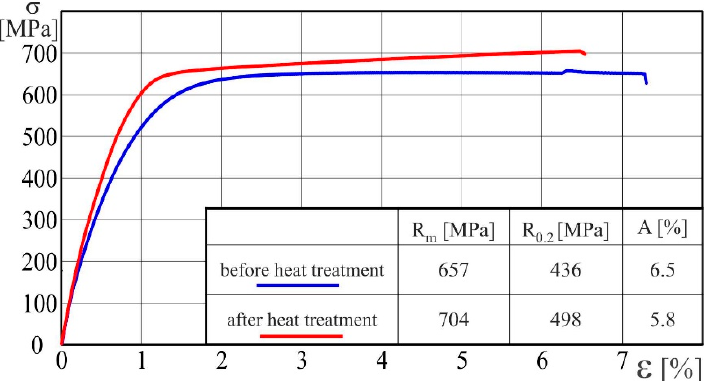
Figure 10. Stress–strain curves of AA2519-Ti6Al4V laminate with interlayer of AA1050 in production state and after heat treatment.